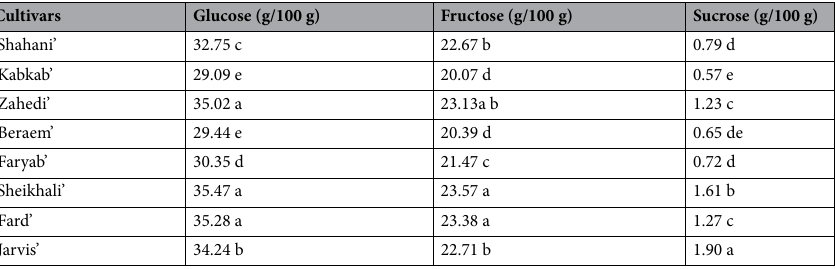
Table 8. The amount of glucose, fructose and sucrose sugars in ‘Piarom’ date fruit (tamar stage) after pollination with eight pollinating cultivars. Different letters within columns indicate significant differences according to Duncan’s multiple range test (p < 0.05).